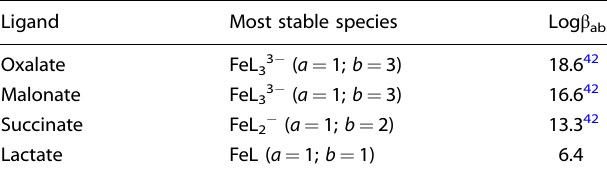
Table 1. Stability constants of ferric iron-ligand (Fe – L) complexes. Ligand